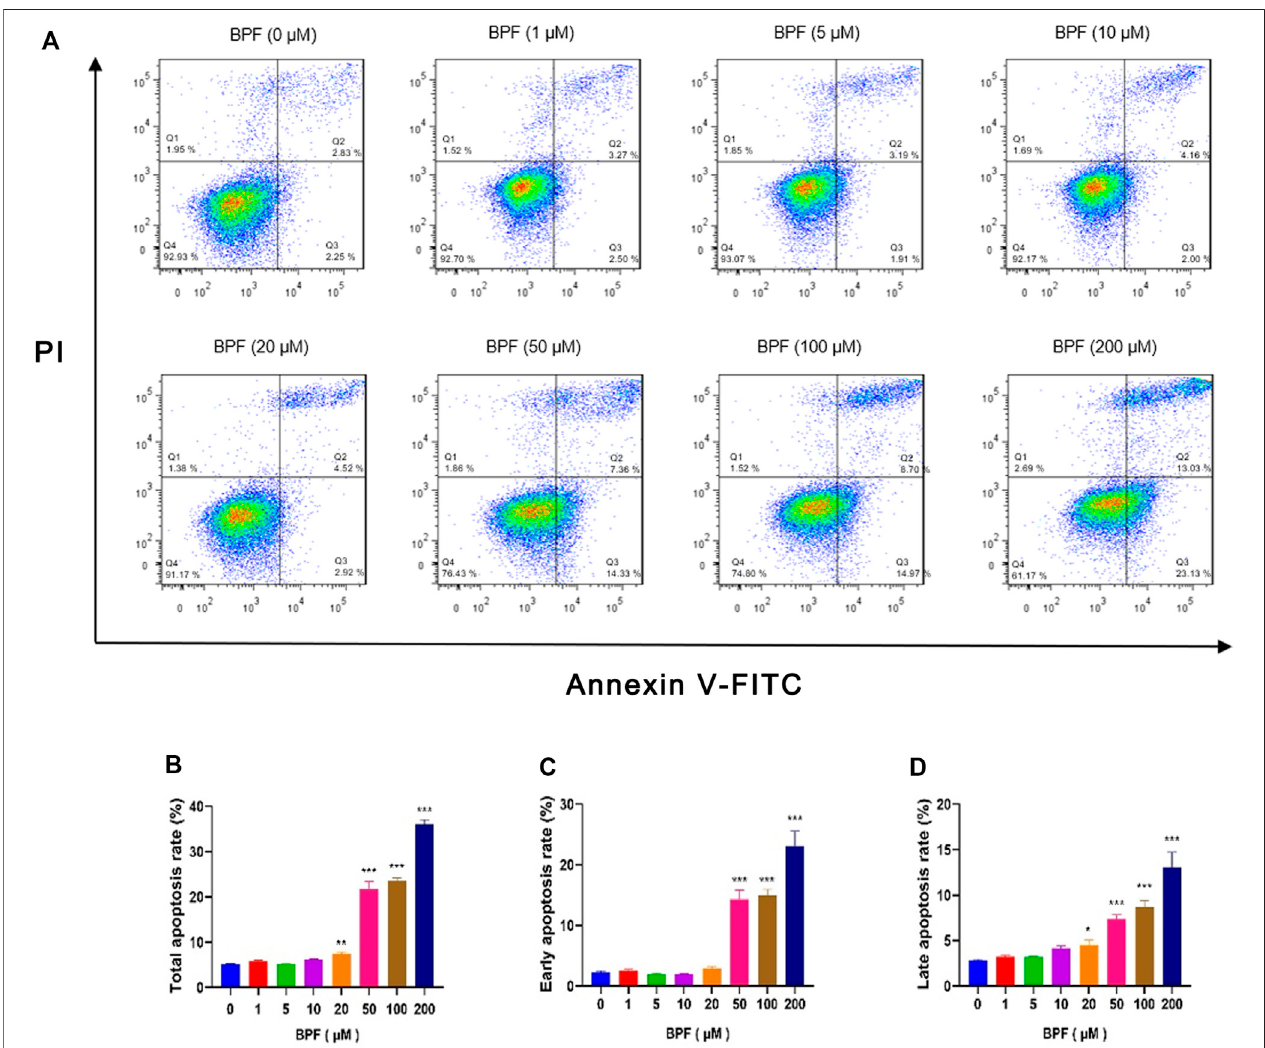
FIGURE 2 | Apoptosis induced by BPF on RAW264.7 macrophages. (A) Flow cytometry was used to analyze the cell apoptosis status of RAW264.7 ( n = 3). (B) The total apoptosis rates. (C) The early apoptosis rates. (D) The late apoptosis rates. Data are expressed as means ± SEM. * p < 0.05, ** p < 0.01, and *** p < 0.001 are compared with the control group (0 μ